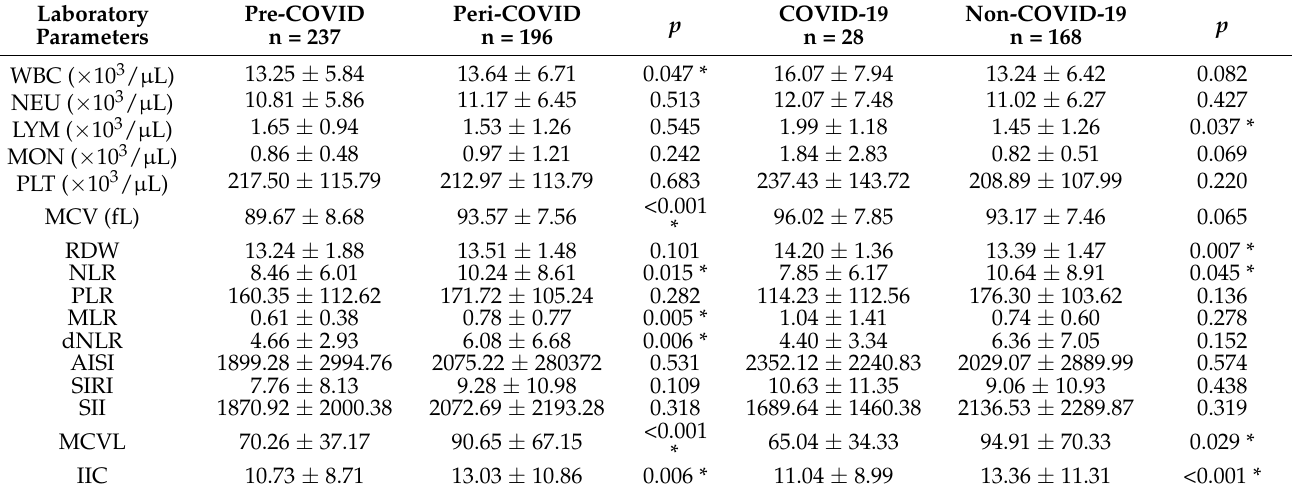
Table 4. Comparison of laboratory parameters and inflammatory markers between pre-COVID and peri-COVID groups in PA